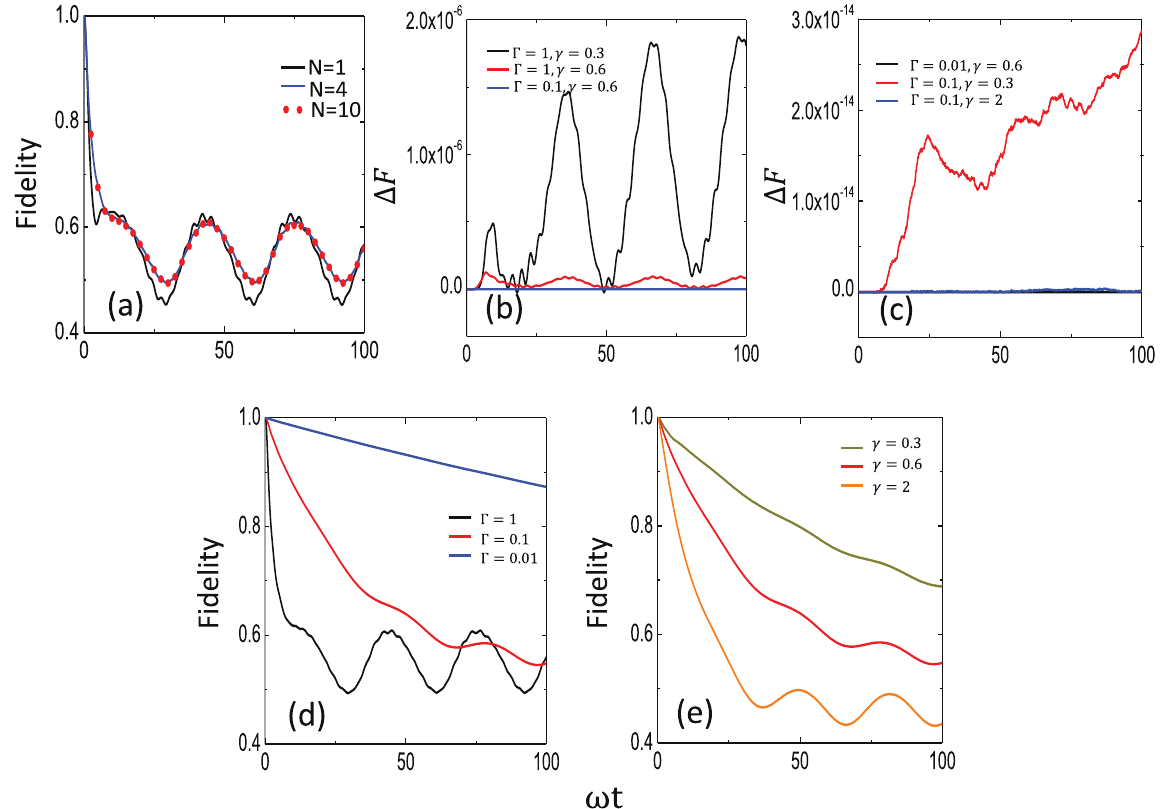
Figure 2. Fidelity evolution of the dark state. ( a ) Fidelity of the dark state calculated at different order  of the hierarchical equation in Eq. (15). The parameters of the two baths are Γ = 1 and γ = 0.6. ( b ) and ( c ) Fidelity difference ∆ ≡ − F F F at different values of the bath parameters, where F ( F ) is the fidelity of the dark 10 20 10 20 state calculated using the hierarchical equation up to the order of  = 10 (20). ( d ) Fidelity of the dark state calculated at different values of Γ , where γ = 0.6 and = 10  . ( e ) Fidelity of the dark state calculated at different values of γ , where Γ = 0.1 and  = 10 . In this figure and the following one, the parameters of the three-level system are ω = − 1 , ω = − . 1 2 , ω = 0 , Ω = . 0 5 , and Ω = . 0 2 1 2 3 1 2